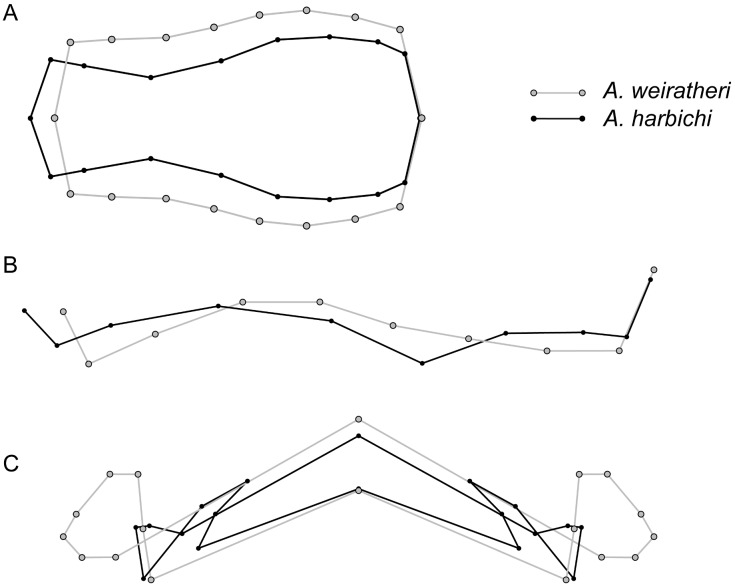
Non-amplified mean differences in pronotum shape between A. weiratheri and A. harbichi, shown in dorsal (A), lateral (B), and frontal (C) view.